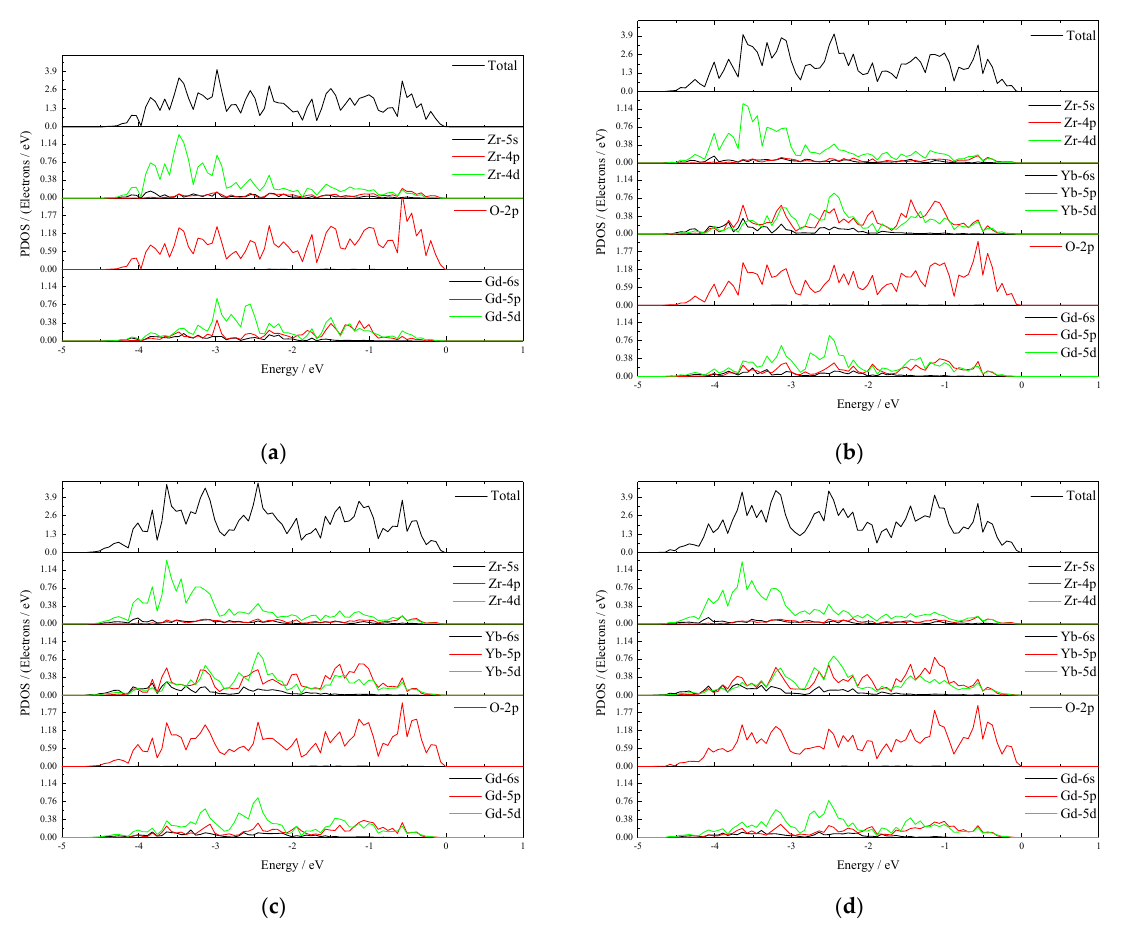
Figure 5. Partial density of states of (Gd 1-x Yb x ) 2 Zr 2 O 7 : ( a ) x = 0; ( b ) x = 0.125; ( c ) x = 0.3125; ( d ) x = 0.5.